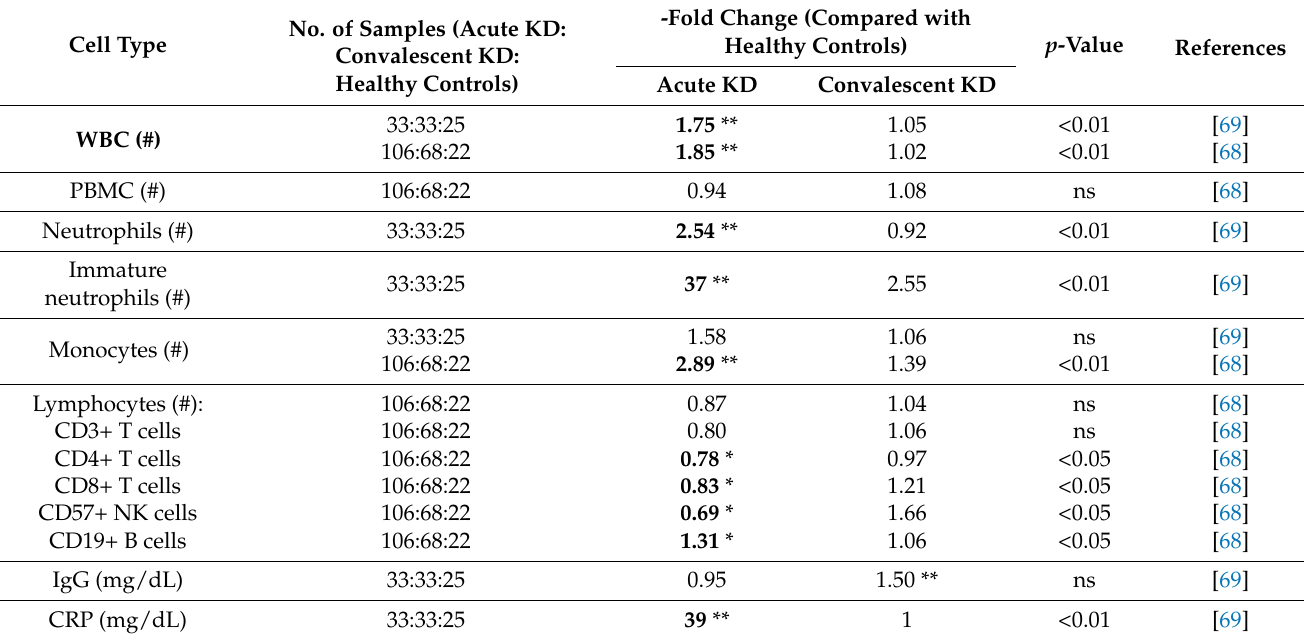
Table 3. Changes in WBC composition during the acute stage of